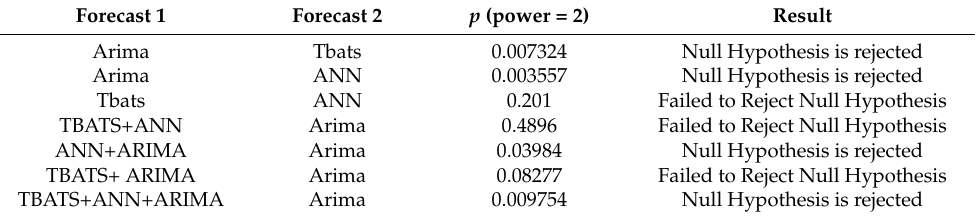
Table 10. Comparing predictive accuracy through the Diebold-Mariano test (Power of